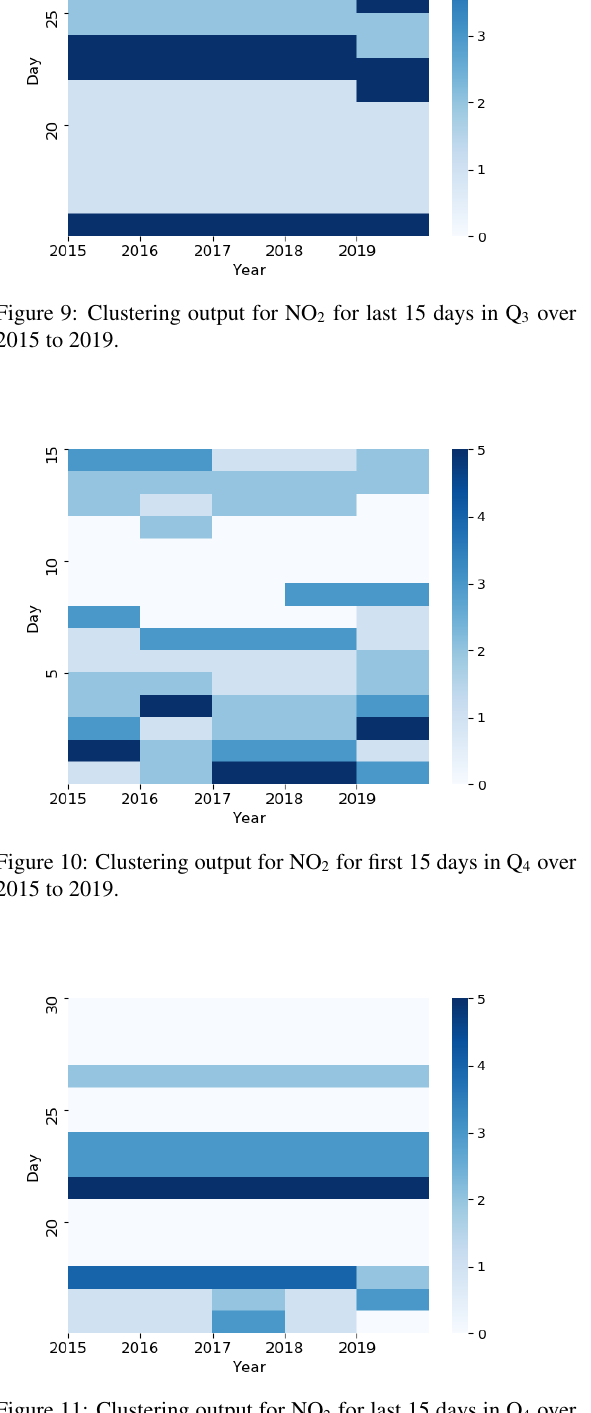
Figure 11: Clustering output for NO 2 for last 15 days in Q 4 over 2015 to